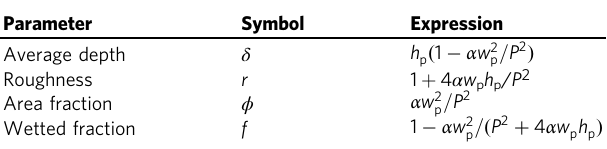
Fig. 1c we examine all pinned states for a texture we study in detail throughout: SQ1, a square array of square pillars, with water as the rising liquid (see Methods, Table 4 for a full description of all systems and abbreviations). For a single value of the plate separation δ / d = 5.43 and contact angle θ = 58°, 73 metastable states are observed. Each state is distinguished via its rise height in the capillary region, C + M (shown on the horizontal axis), and the hemiwicking height H (shown on the colour scale), normalised relative to the simulated pitch length P .